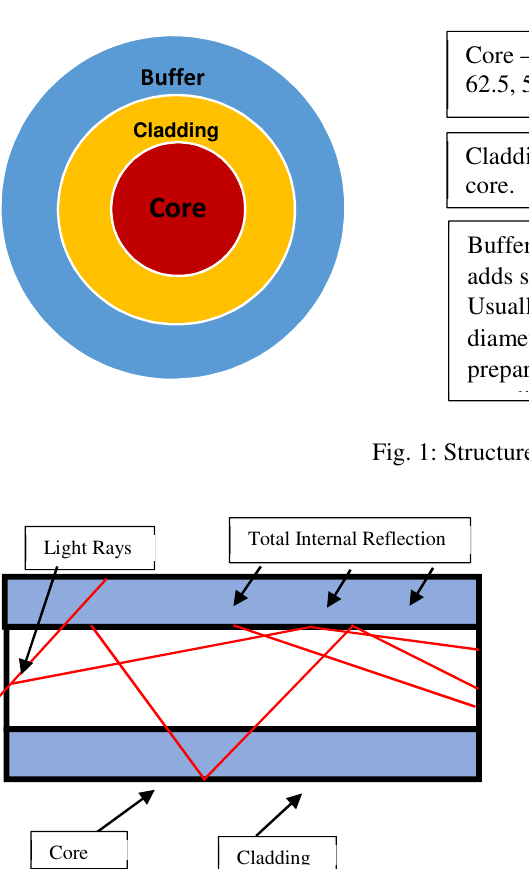
Fig. 2: Illustration of Total Internal Reflection